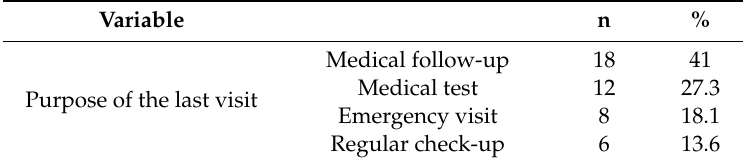
Table 2. Healthcare user purpose of the last visit to the healthcare facility.